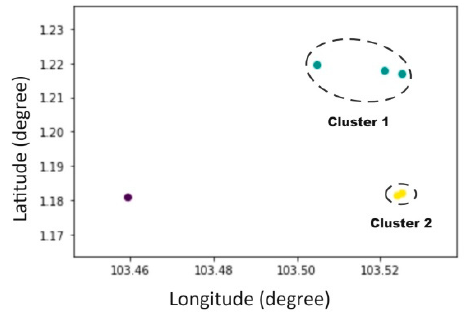
Figure 10. Result of DBSCAN at 1820.